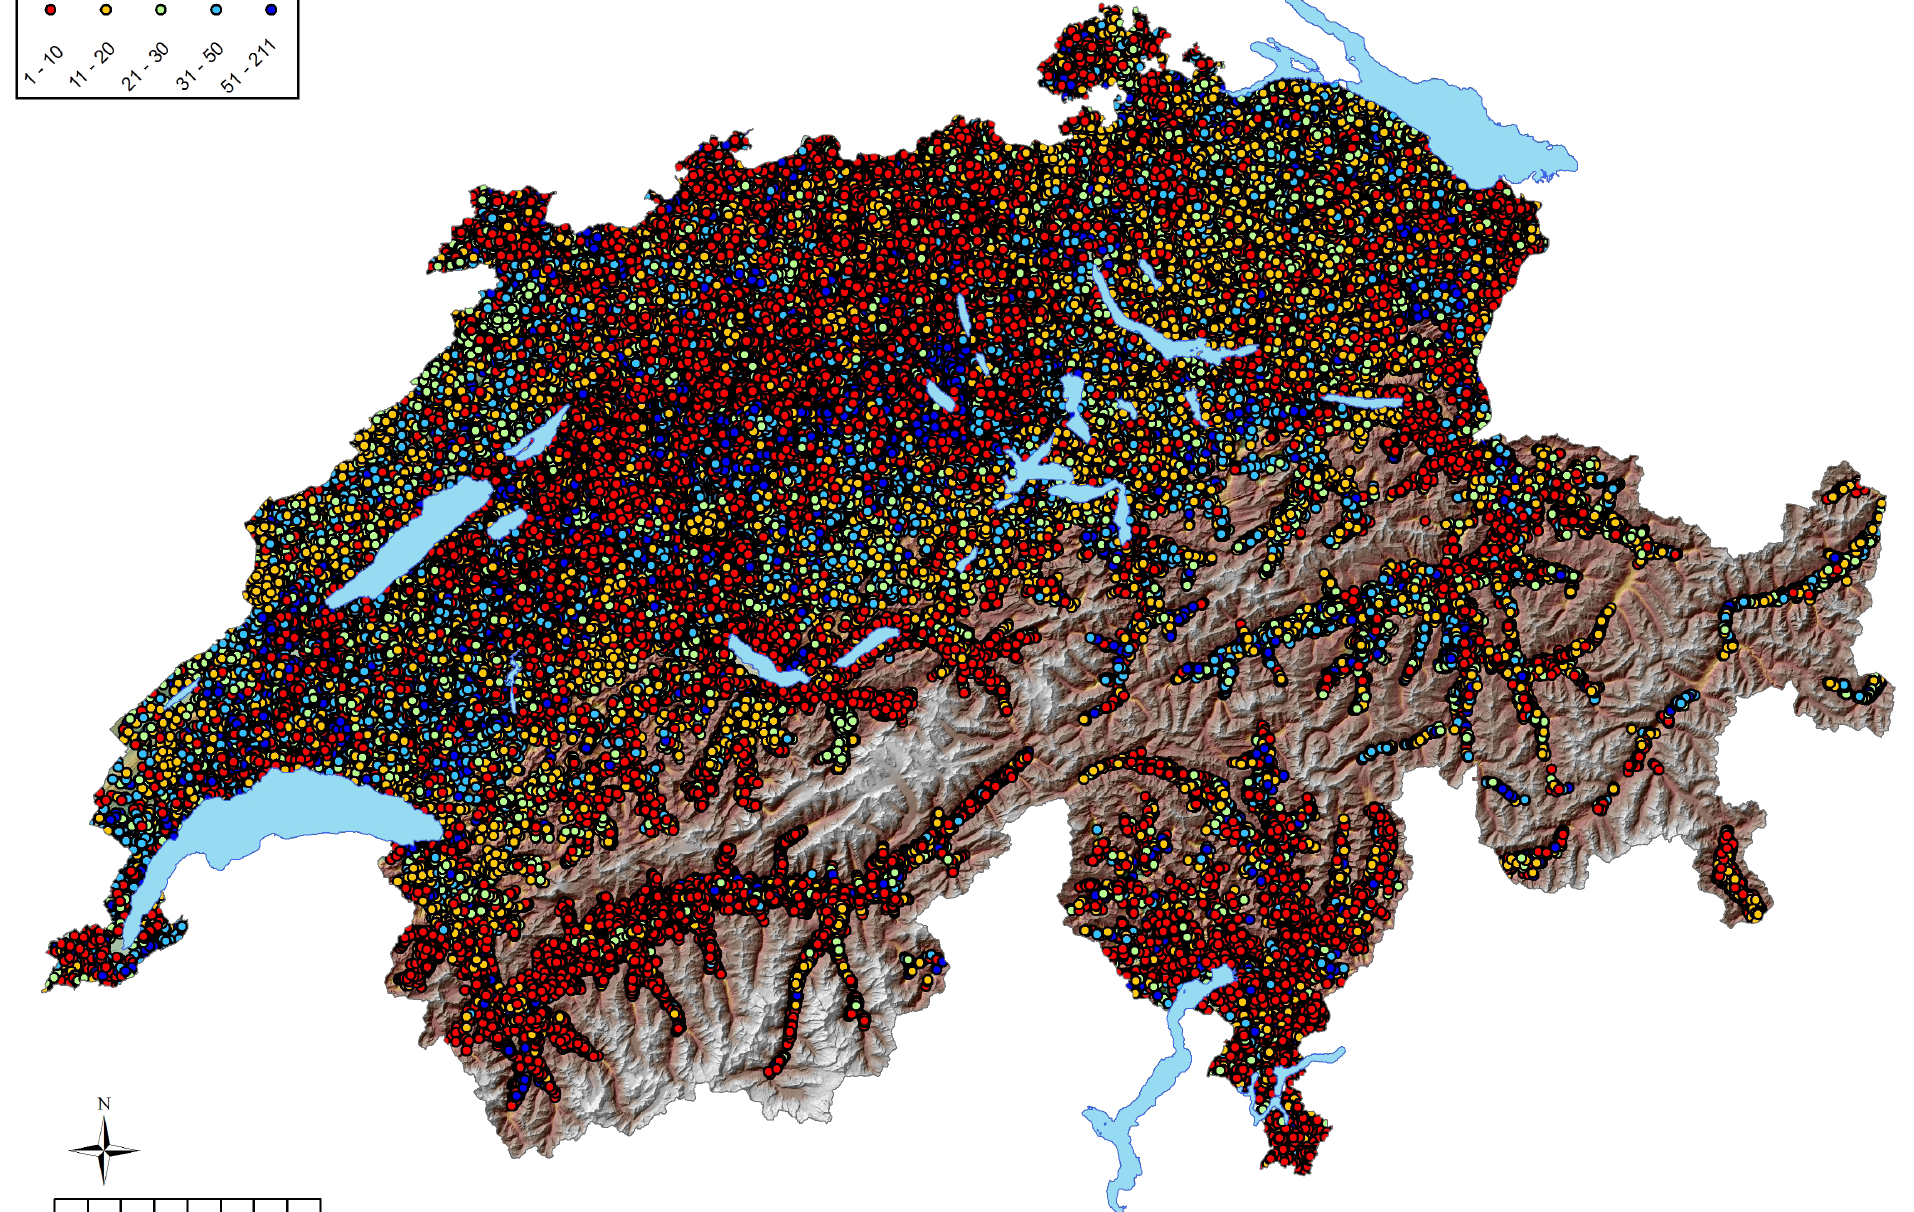
Figure S1: Map of Switzerland (including lakes) with the distribution of premises sizes of the reconstructed livestock premises in